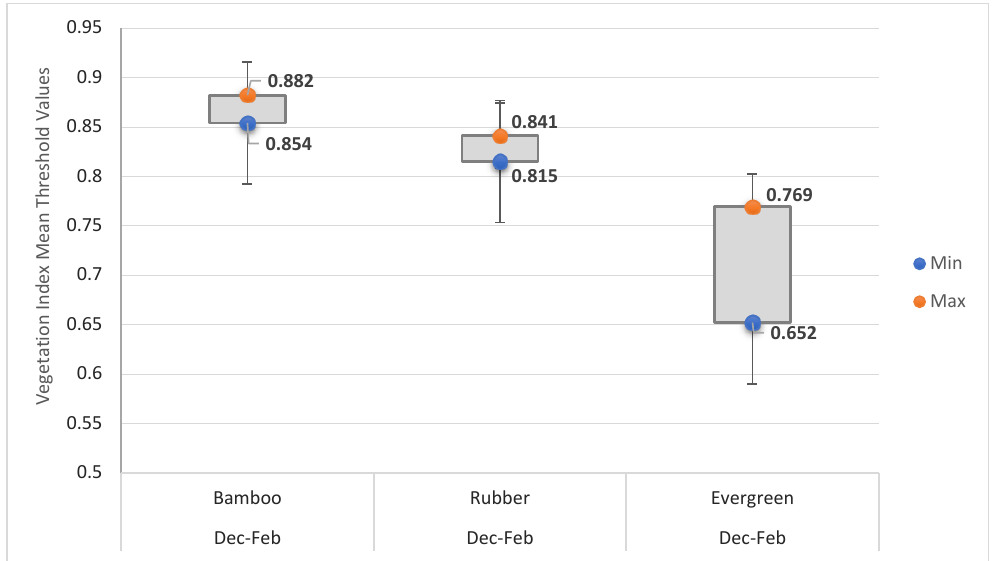
Figure 10. Minimum and maximum threshold values for bamboo forest, rubber plantation, and evergreen forest determined using Landsat 8 OLI EVI time-series data during the mid-LSP stage from 2015 to 2018.